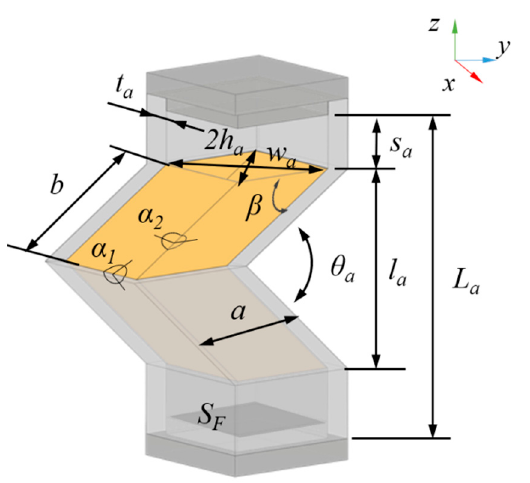
α α θ (cid:44) 0 1b , 2b , b when the P A